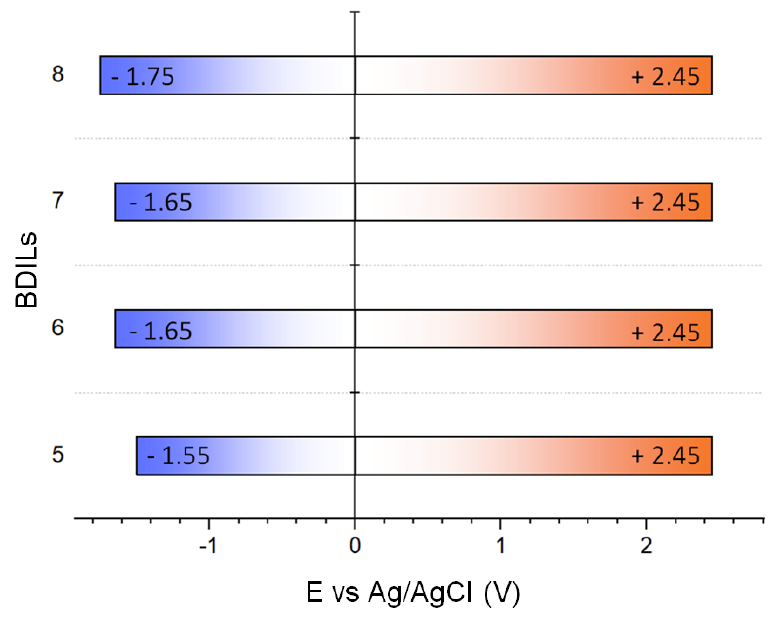
Figure 4. Operative range of Tf 2 N BDILs: the blue bars and green bars were obtained by using a